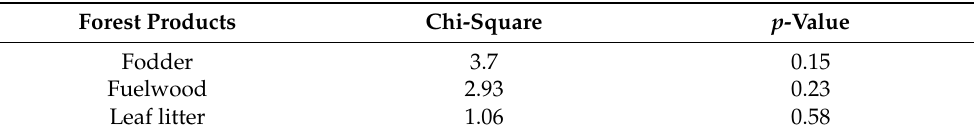
Figure 3. The average annual supply of forest products from different agroforestry systems in kilograms; ( a ) fodder, ( b ) fuelwood and ( c ) leaf litter where a red dot indicates the mean while a black line indicates the median.